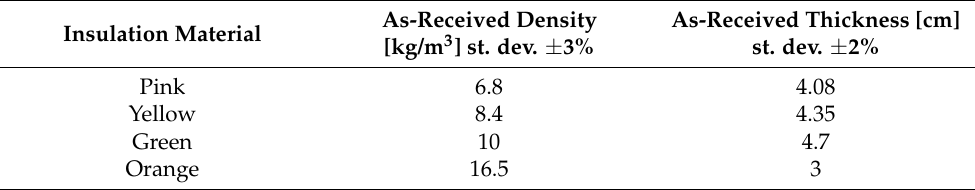
Table 1. The density and thickness of the as-received